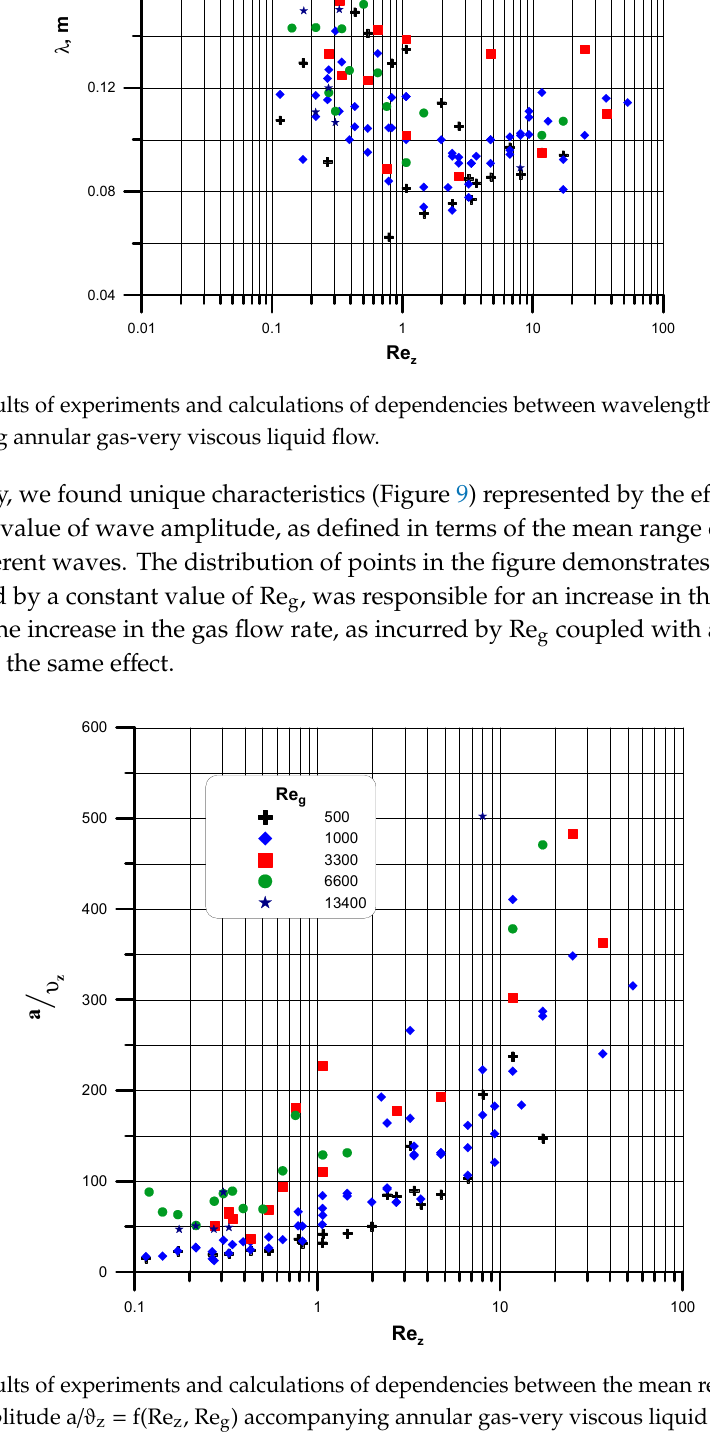
Figure 7. Results of experiments and calculations of wave velocity c = f(Re z , Re g ) accompanying annular gas-very viscous liquid flow.